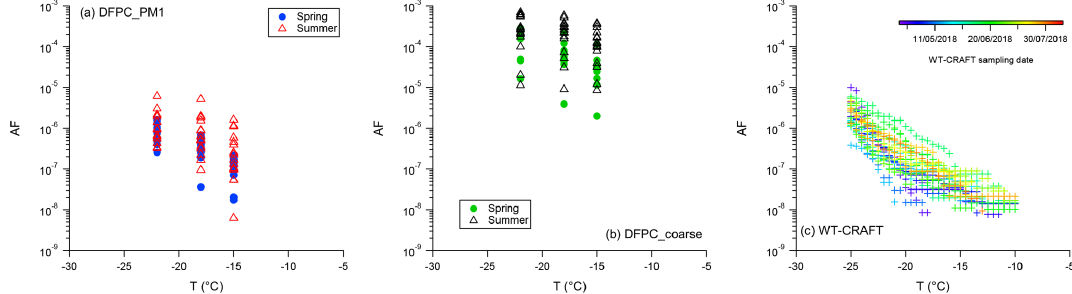
Figure 3. AF as a function of T assessed for samples from GVB during 2018 by DFPC in the sub-micrometer (a) and coarse (b) size ranges and by WT-CRAFT (c) . Particle size ranges used to calculate AF are 0.1–1, 0.1–10 and 0.1–10µm for the DFPC PM 1 , DFPC PM 10 and WT-CRAFT samples,